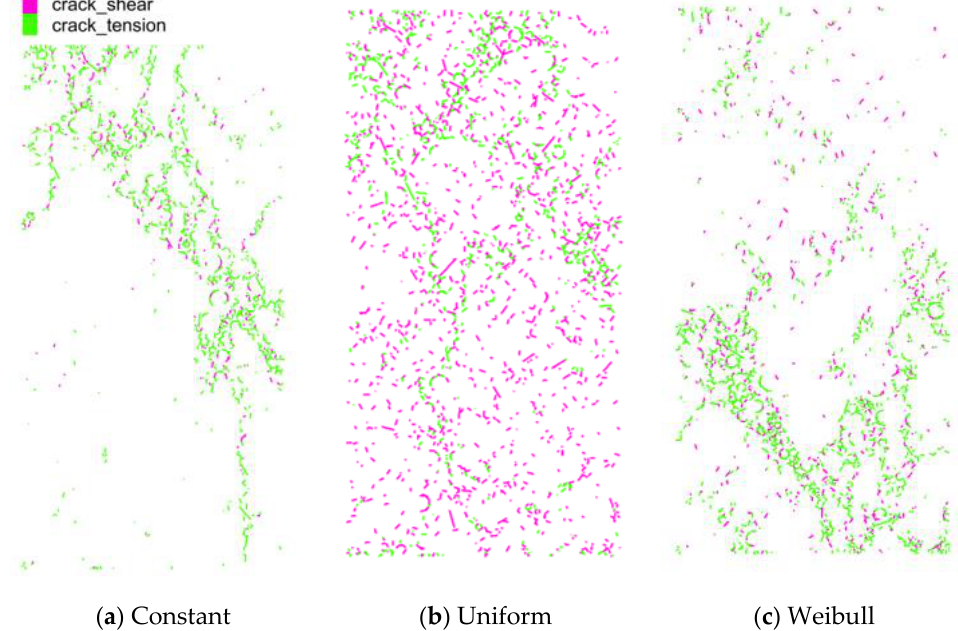
Figure 13. Crack patterns of the cases with different interface